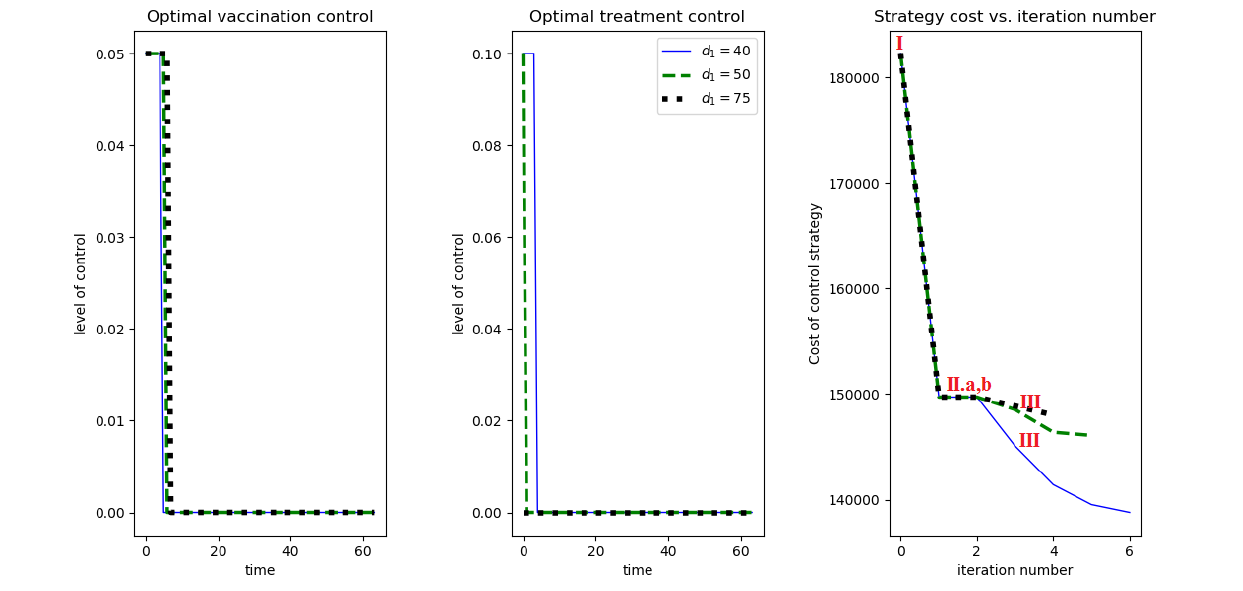
Figure 12. Optimal vaccination, treatment controls and strategy cost for different values of d 1 .